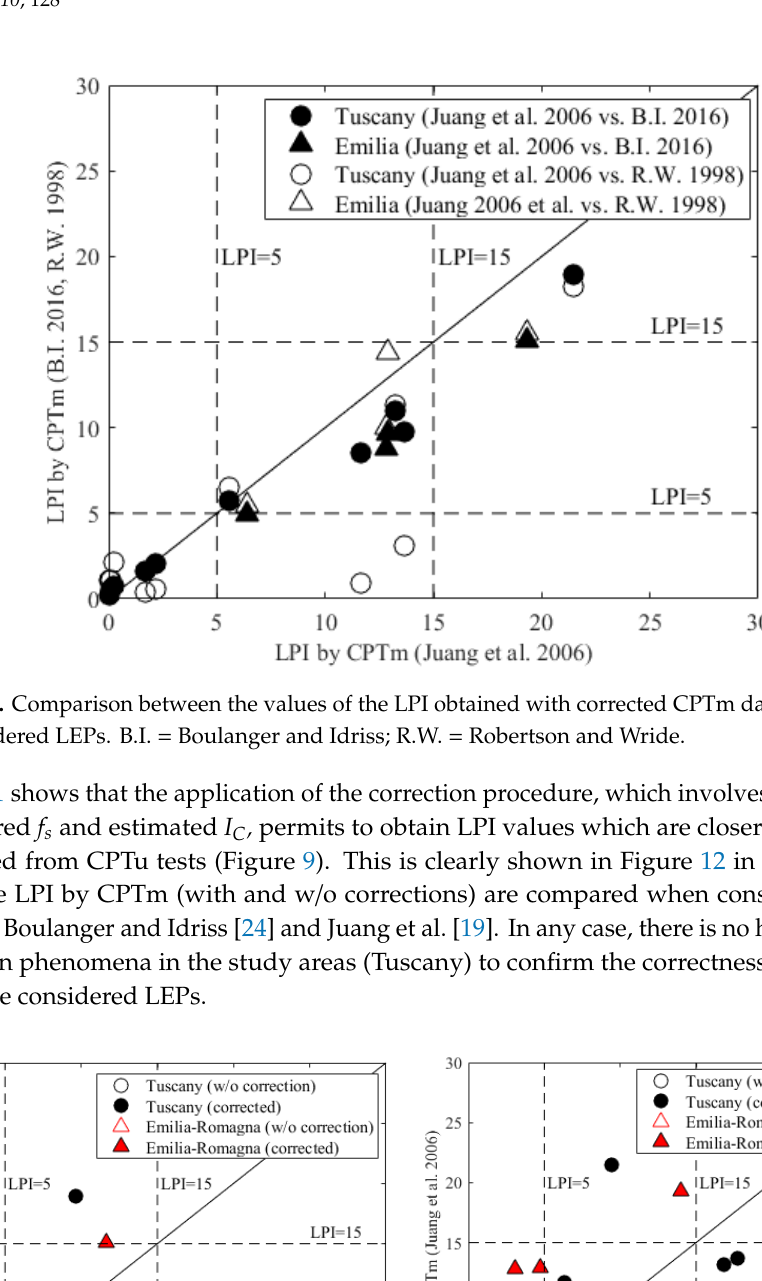
Figure 10. Comparison between the values of the LPI obtained with uncorrected CPTm data by using